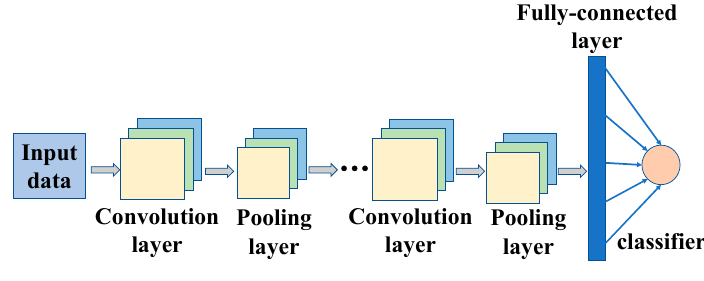
Figure 1. CNN structure.